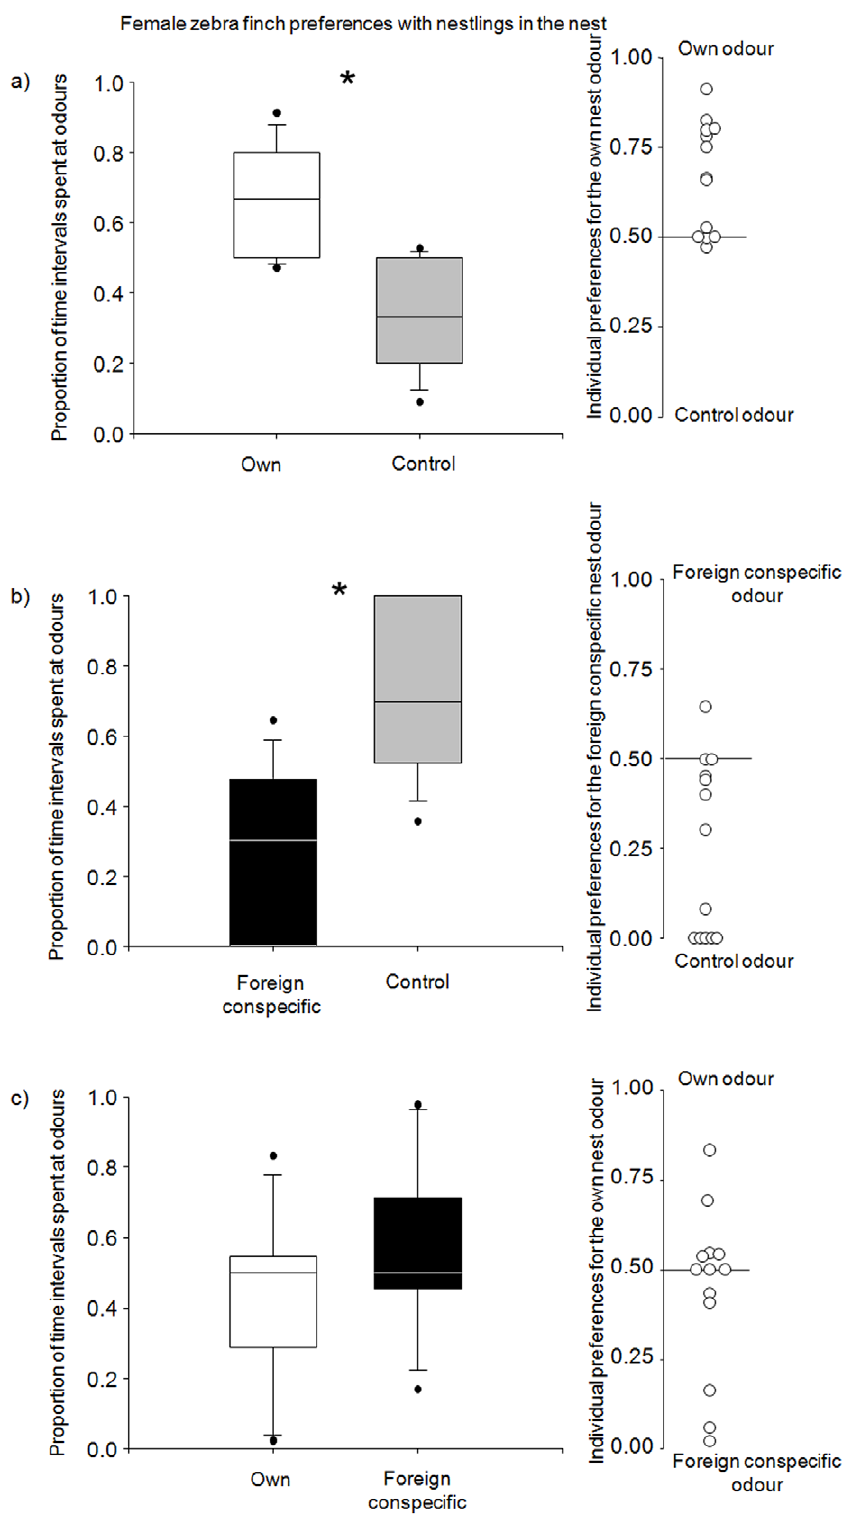
Figure 1. Female zebra finch preferences in three olfactory choice tests. Females were tested in the different test situations (a–c), always having the choice between two different odours. The average (left side) and individual results as dots (right side) of the odour preference test for the adult breeding zebra finch females with 10 day old nestlings in the nest, when tested with a) own nest odour against control odour (Wilcoxon-test, N=13, Z= 2 2.667, p=0.008), b) foreign conspecific nest odour against control odour (Wilcoxon-test, N=13, Z= 2 2.606, p=0.009) and c) own nest odour against foreign conspecific nest odour (Wilcoxon-test, N=13, Z= 2 0.866, p=0.39).